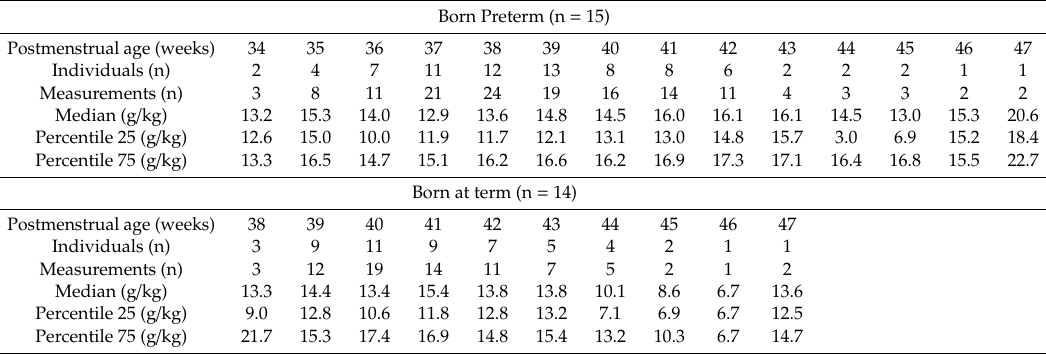
Table 3. Daily carbohydrate intake in infants born preterm and at term.